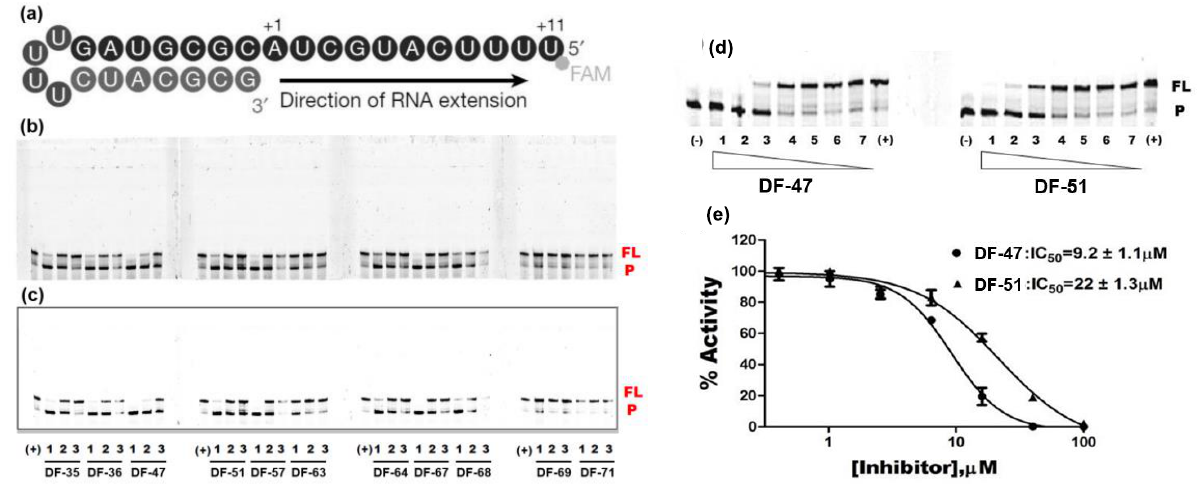
Figure 3. Inhibition of RNA-dependent RNA polymerase activity of 11 compounds. ( a ) Graphic representation of the 5′-6 FAM-labeled hairpin RNA substrate as primer-template used to monitor the inhibition of SARS-CoV-2 RdRp activity. +1 and +11, the positions of the first and the last nucleotide incorporated, respectively. ( b ) Gel picture with auto-contrast. Compound concentration: 1. 20; 2. 10; 3. 5 µM; (-): reaction in the absence of rNTPs; (+): reaction in the absence of com- pound. P: FAM-labeled RNA primer; FL: full-length RNA product. The data shown are from one representative experi- ment. ( c ) Gel picture with adjusted contrast. ( d ) Gel pictures of DF-47 and DF-51 . The concentrations of the compounds used are as follows: 1. 100; 2. 40; 3. 16; 4. 6.4; 5. 2.6; 6. 1; 7. 0.4 µM. ( e ) Dose–response curves of DF-47 and DF-51 .